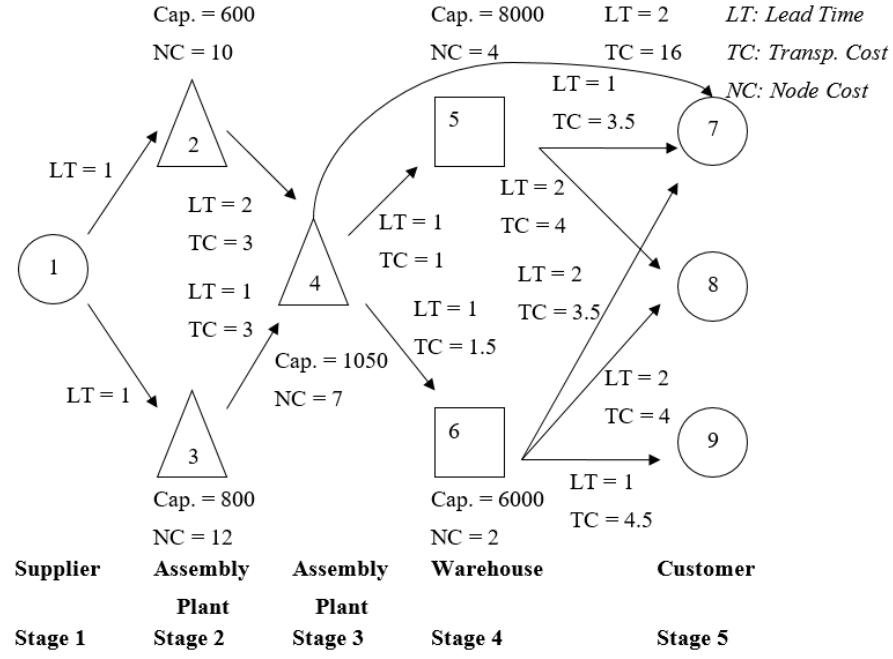
Figure 1. Example of a supply chain network.